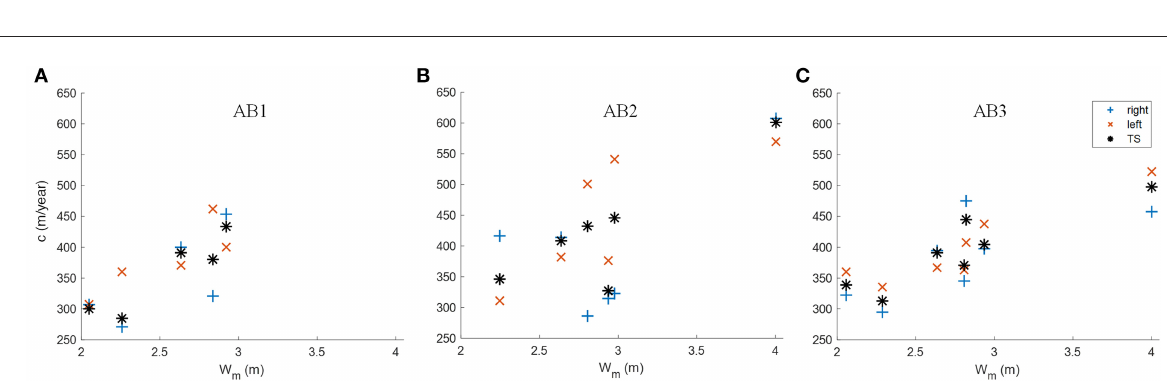
(TS) of each cross-sectional profile by a linear